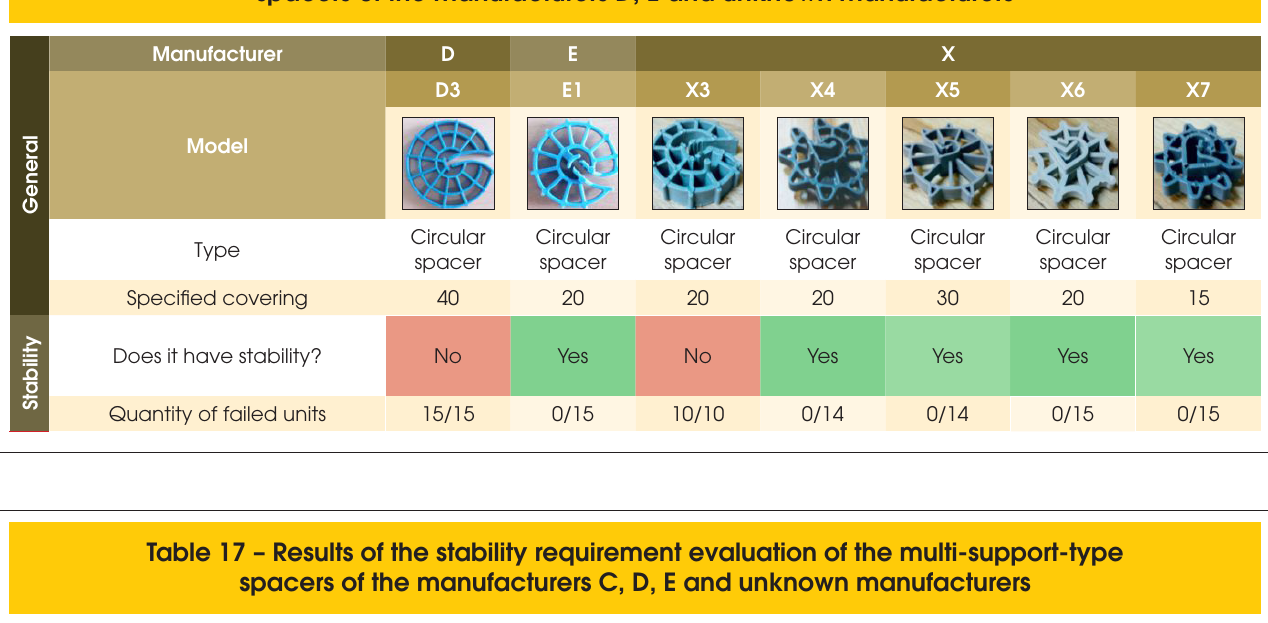
Table 16 – Results of the stability requirement evaluation of the circular-type spacers of the manufacturers D, E and unknown manufacturers